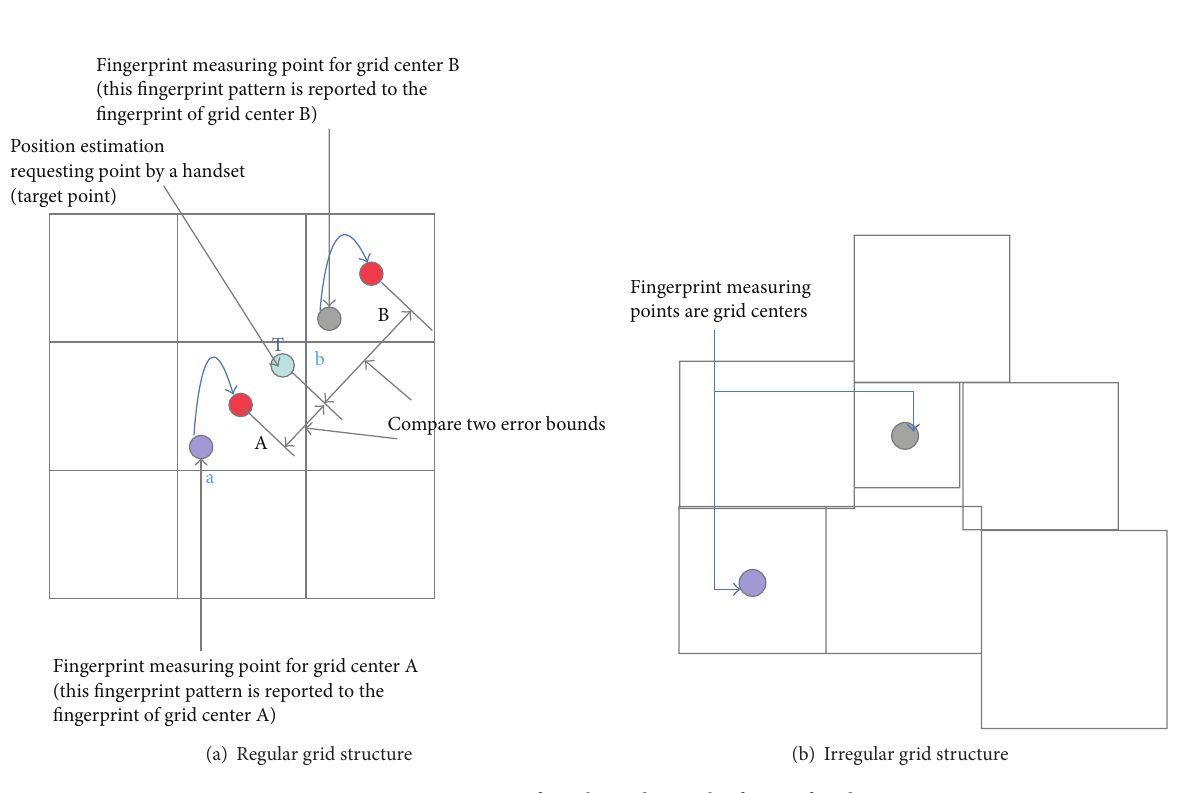
Figure 2: Comparison of regular and irregular forms of grids.